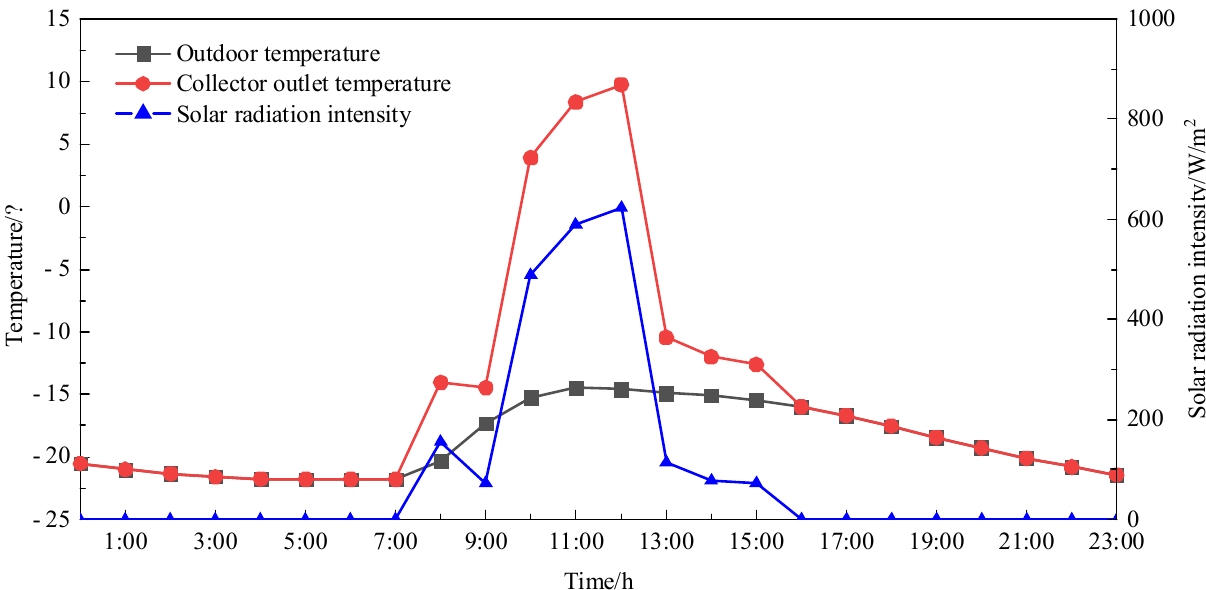
Figure 6. The import and export temperature and solar radiation intensity for typical meteorological solar collectors in winter in Harbin.